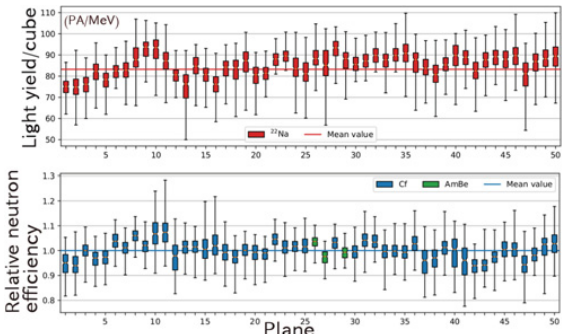
Figure 8. Integral over Amplitude versus Amplitude, in Pixel- Avalanches (PA) for reconstructed NS candidates from data taken with a 252 Cf source. The red dashed line shows the cut used for Particle Identification. Right: projection on the Integral over Amplitude axis for selected and rejected events.